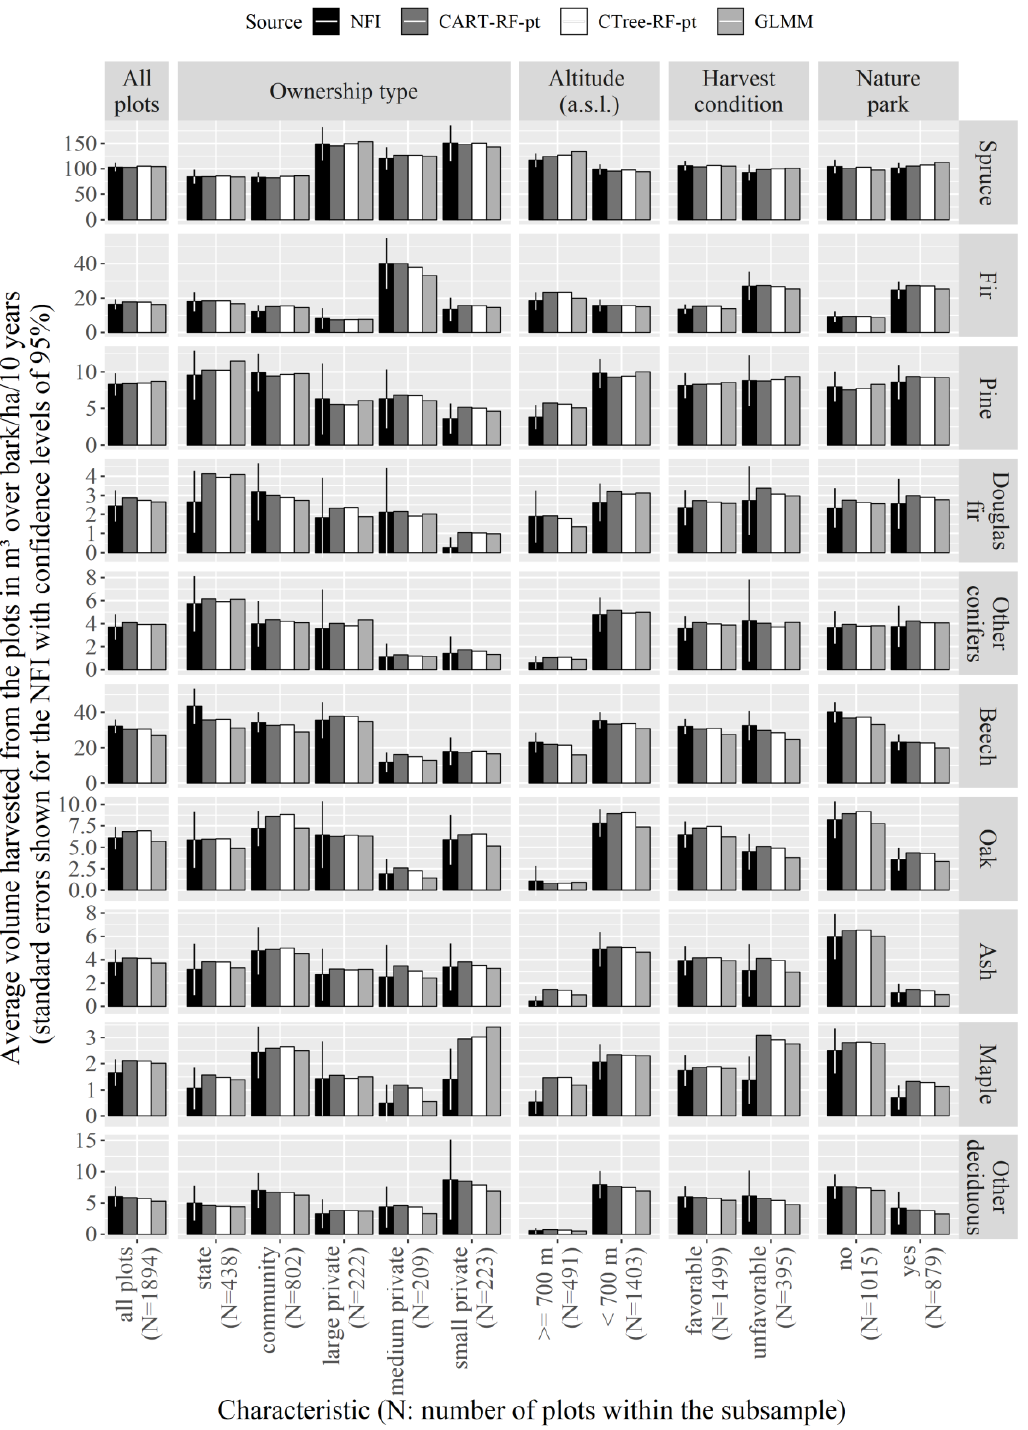
Figure 2. Comparing 2002–2012 predicted average harvested volumes (tree-level models only) for plots on which harvests occurred according to the national forest inventory (NFI) for species (groups) and selected data subsets. Harvested volumes refer to the average of the plots included in the respective test set subsample (N). The reference year for the diameter at breast height (DBH) classes and harvested volumes was 2007 (CART: Classification and regression tree; CTree: Conditional inference tree; RF: Random forest; pt: variation that used plot- and tree-level attributes; GLMM: Generalized linear mixed model; a.s.l.: above sea level).